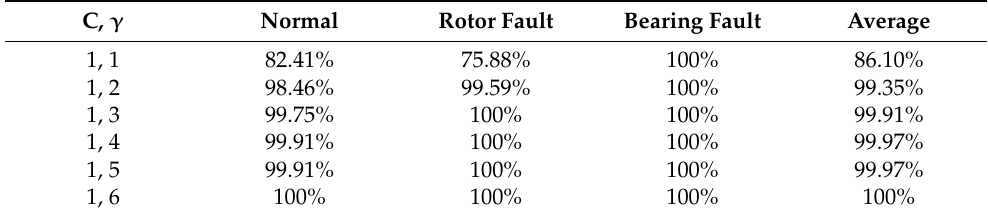
Table 3. Diagnostic accuracy of support vector machine through two-fold cross validation.